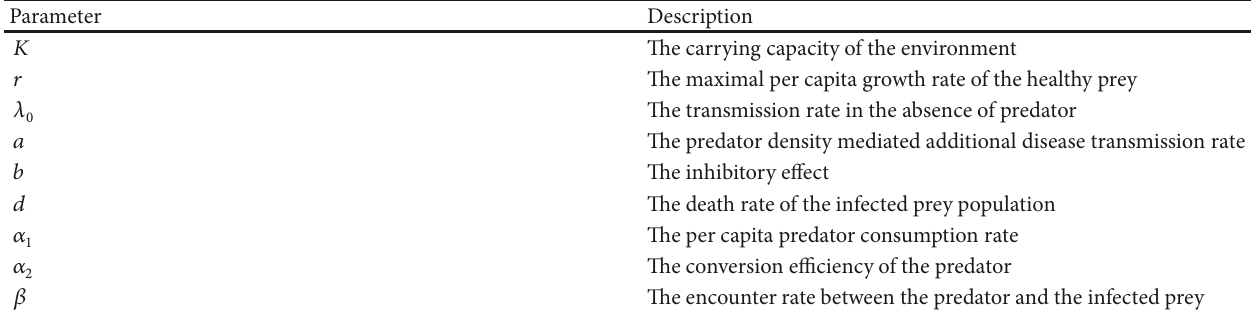
Table 1: Parameters and their meanings in this